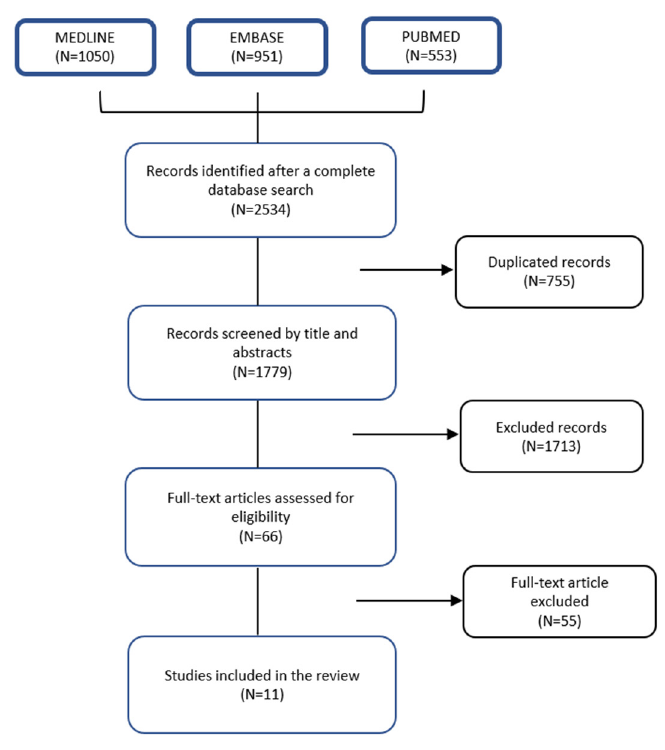
Figure 1. Study Figure 1. Study flowchart.